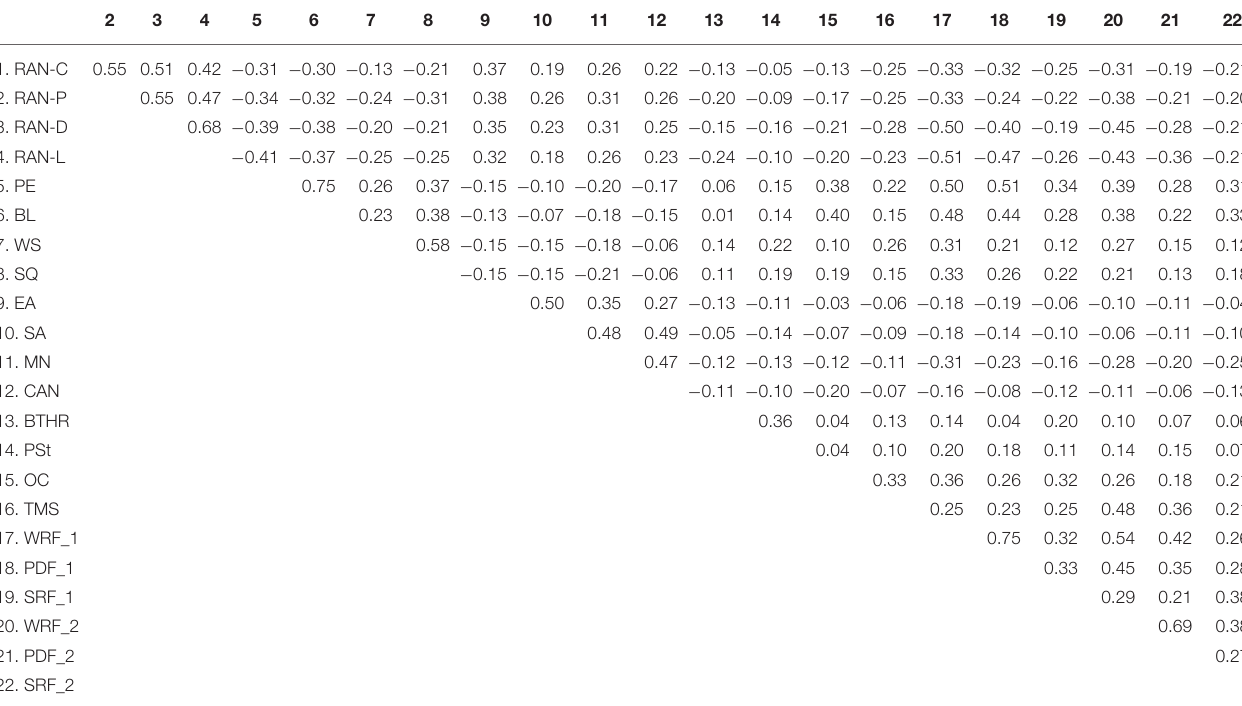
TABLE 2 | Correlations Among all Measures in Grades 1 and